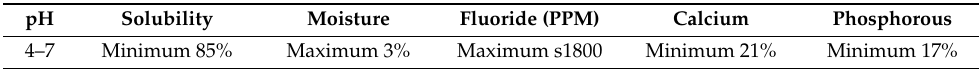
Table 1. Chemical properties of fine silica sand used in this